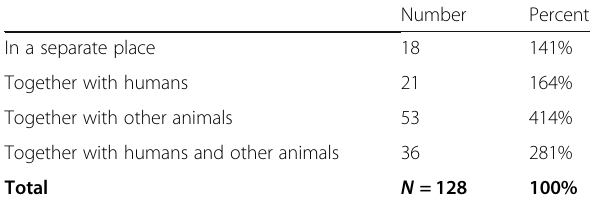
Table 1 Where do chickens stay overnight?